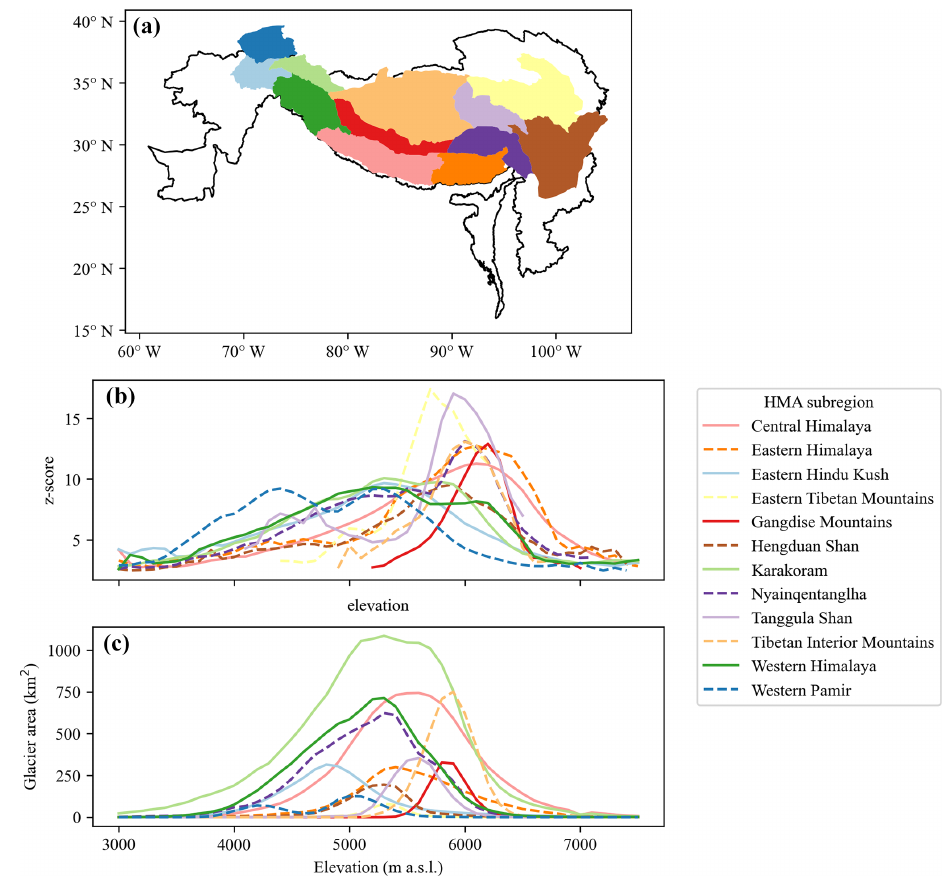
Figure 4. (a) Glacio-climate sub-regions within the Hindu Kush Himalaya codified in Shean et al. (2020). (b) Mean z score (2017–2019) by 100m SRTM elevation bin over each sub-region in the HKH. (c) Mapped glacier area from the GAMDAM database (Sakai, 2019) over 100m elevation bins derived using the 30m SRTM DEM (Farr, 2007) for each